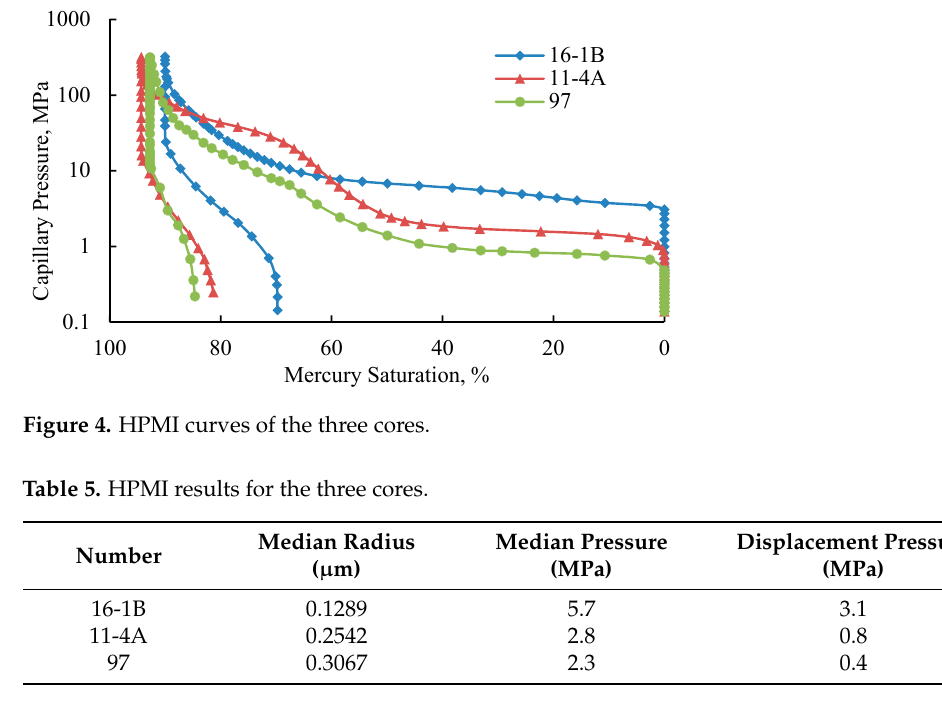
Figure 3. Flowchart of the resistance gradient experiment.